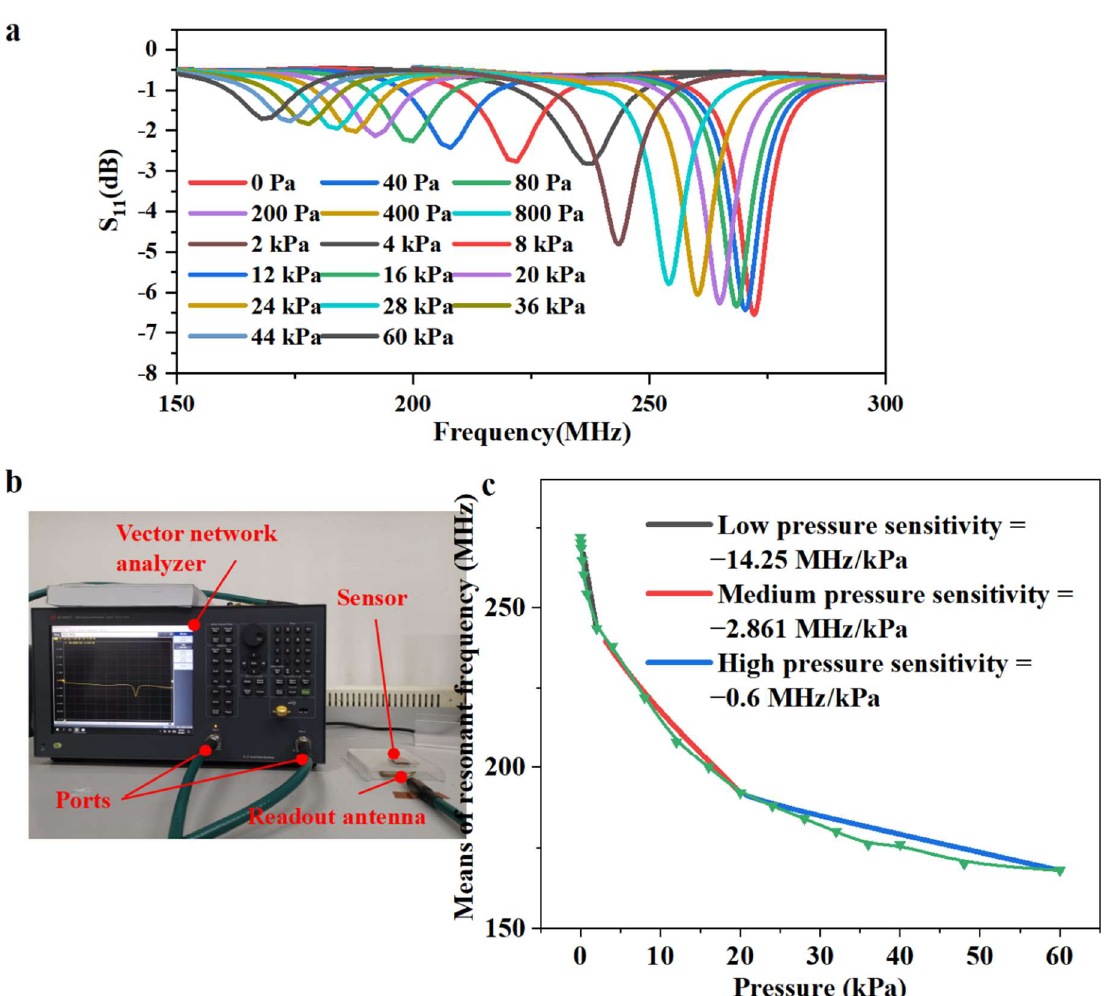
Figure 4. Response characteristics of RF pressure sensors. ( a ) The S11 responses of the sensor with bilayer pyramids structure under pressure gradually increase during low-pressure (0–4 kPa), mid-pressure (4–20 kPa), and high pressure (20–60 kPa) range. ( b ) Optical photograph of the test plat- form. ( c ) Sensitivity curve of the sensor with multi-walled carbon nanotube/polydimethylsiloxane (MWCNT/PDMS) bilayer pyramid array dielectric structure.